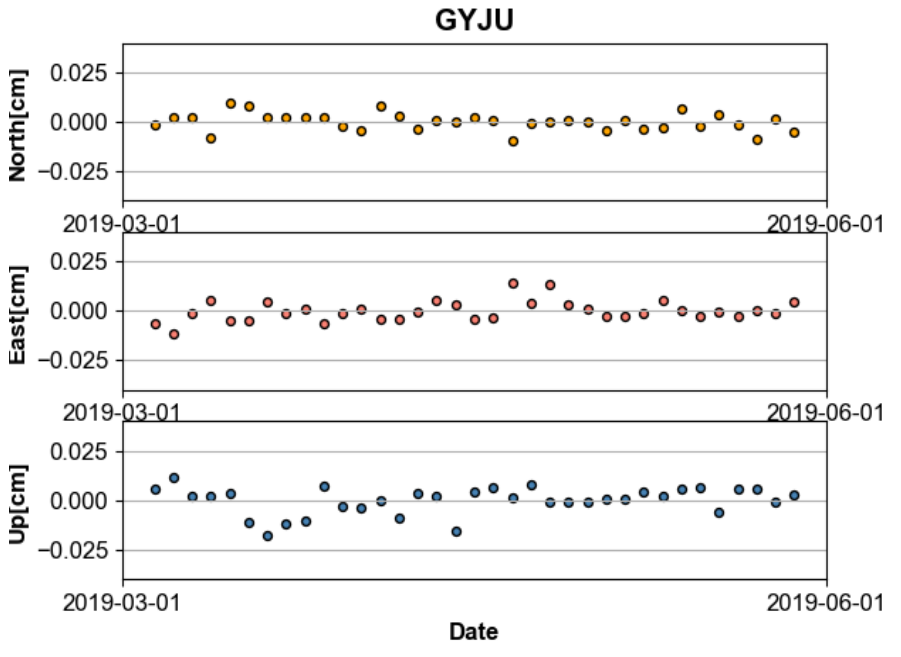
Figure 5. Time series of GYJU